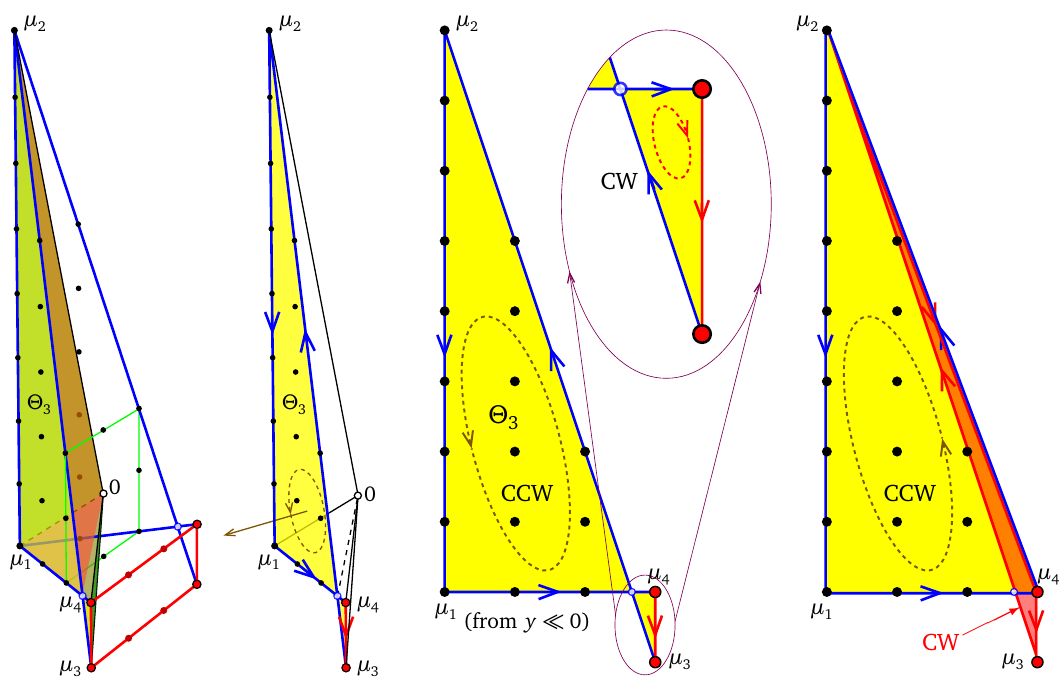
⊂ ∆ : in location within ∆ (cid:70) (cid:70) 3 3 viewed from y (cid:28) 0 and zooming on 3